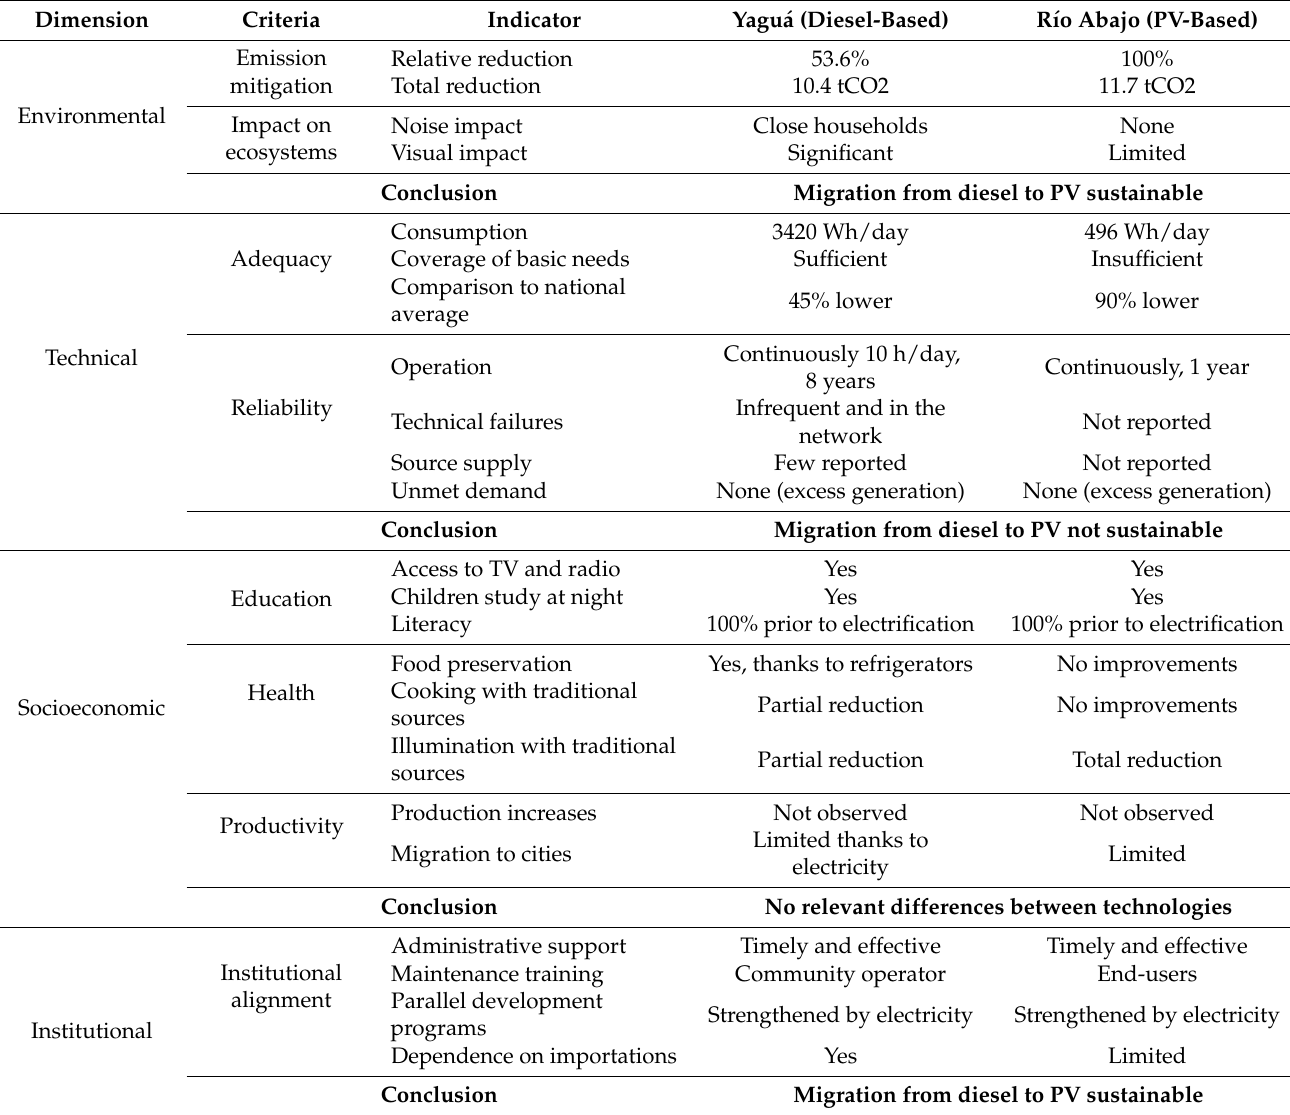
Table 3. Comparison between the electrification projects in Yagu á and R í o